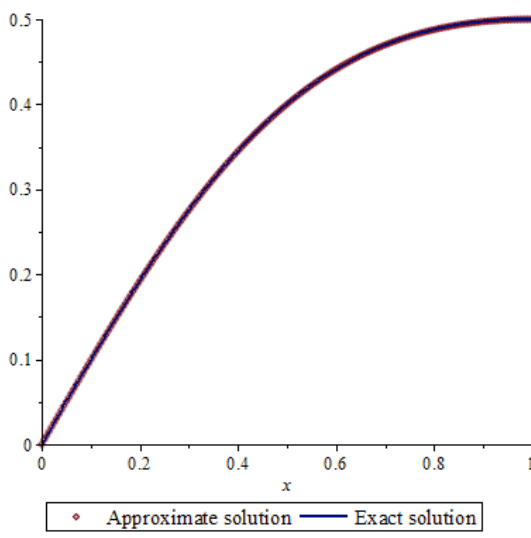
Figure 1. The approach solution U n for n = 10.